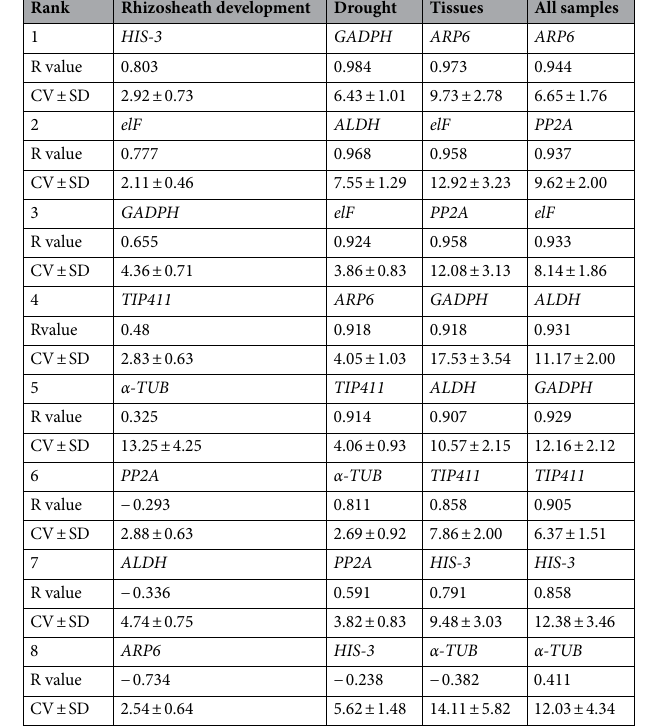
Table 3. Expression stability values of eight candidate reference genes calculated by BestKeeper.